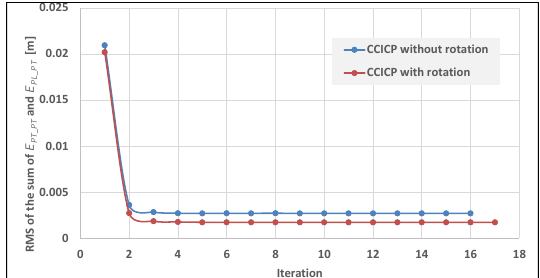
Figure 11. Effectiveness of